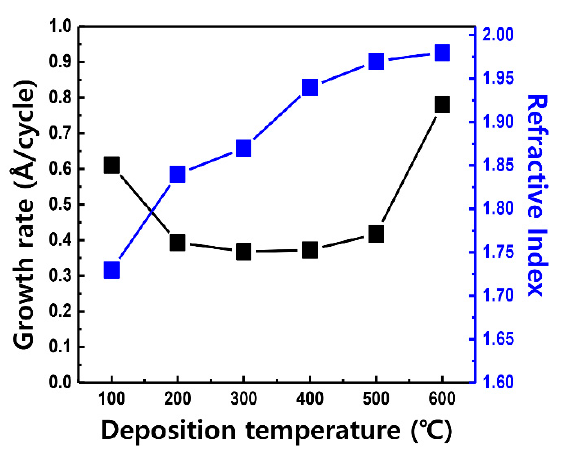
Figure 2. Effect of growth rate and refractive index as a function of deposition temperature at a plasma power of 100 W.